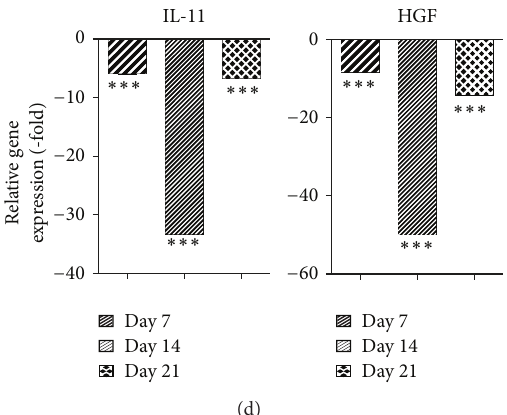
Figure 5: Levels of anti-inflammatory cytokines are elevated during adipogenic differentiation of ASCs. ASCs were grown in CCM and then changed to ADM. After 7, 14, and 21 days, cells were harvested and analyzed by qRT-PCR. Data is normalized to undifferentiated cells. Mean ± SEM. ∗ 𝑃 < 0.05 ; ∗∗ 𝑃 < 0.01 ; ∗∗∗ 𝑃 < 0.001 relative to undifferentiated cells.